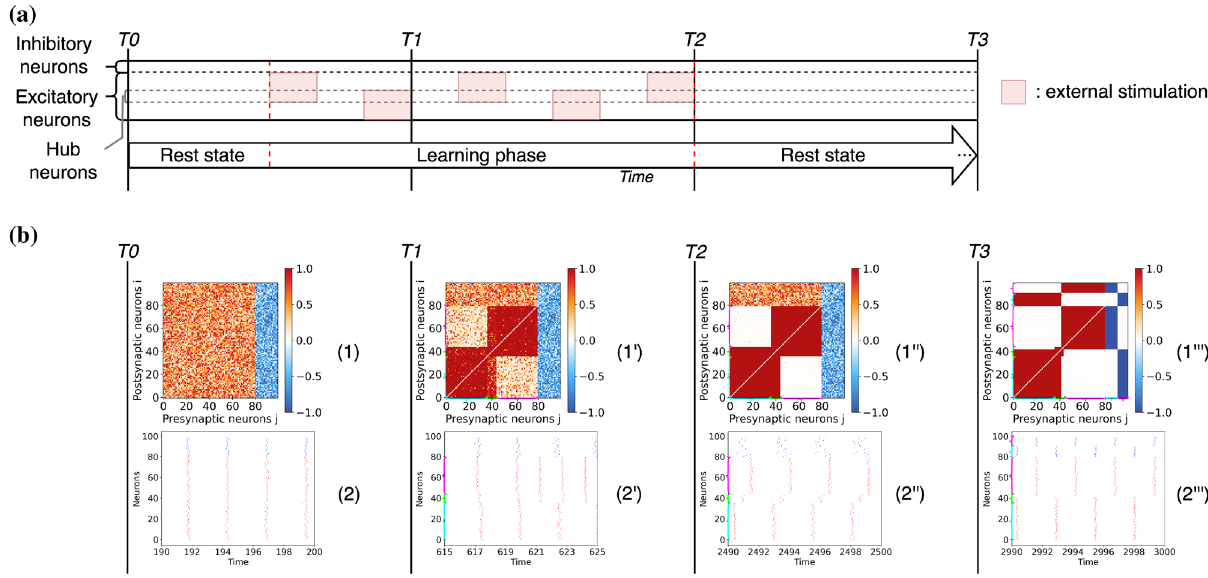
Figure 7. Entrainment of a network of excitatory and inhibitory θ -neurons with two overlapping stimuli. ( a ) Schema of the experiment protocol showing that the two presented stimuli involve 8 shared neurons. ( b ) The results are given at different instants of the simulation. The time labels and the graphs have the same significance and content as in Fig. 3. Note that the inhibitory neurons and the putative hub neurons are sorted by phases at time T3 for visualization purposes. The cyan, magenta and green brackets represent clusters 1, 2 and the hubs respectively when they are visible in weight matrices and raster